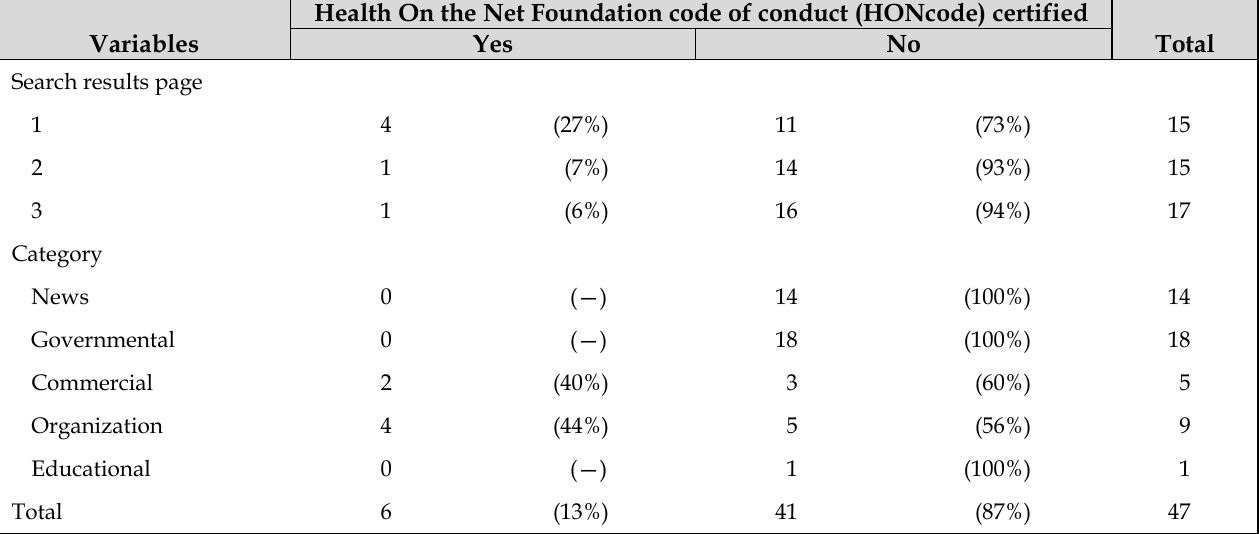
Table 1 Frequency and categorization of websites retrieved via Google